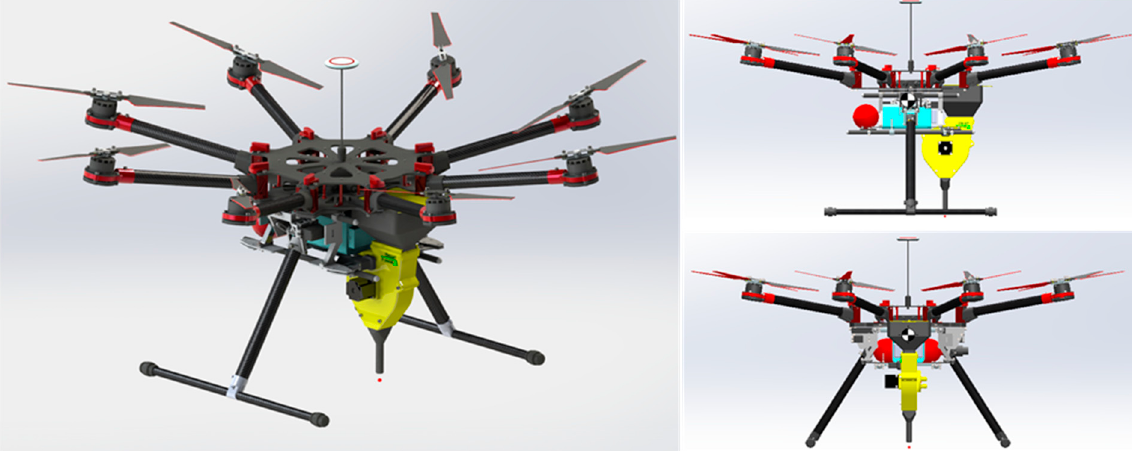
Figure 9. Layout of a vacuum-pneumatic vertical plate precision sowing devices and multicopter DJI SPREADING WINGS S1000+.